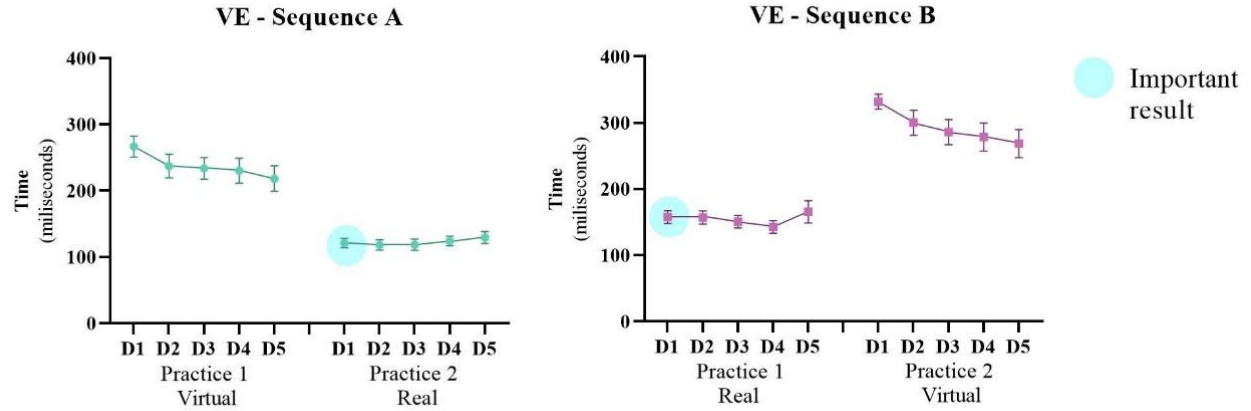
Figure 4. Representation of mean and standard error of the Variable Error (VE) of both Sequences (A: virtual → real and B: real → virtual) during the 10 days of intervention (D1–D5: Days